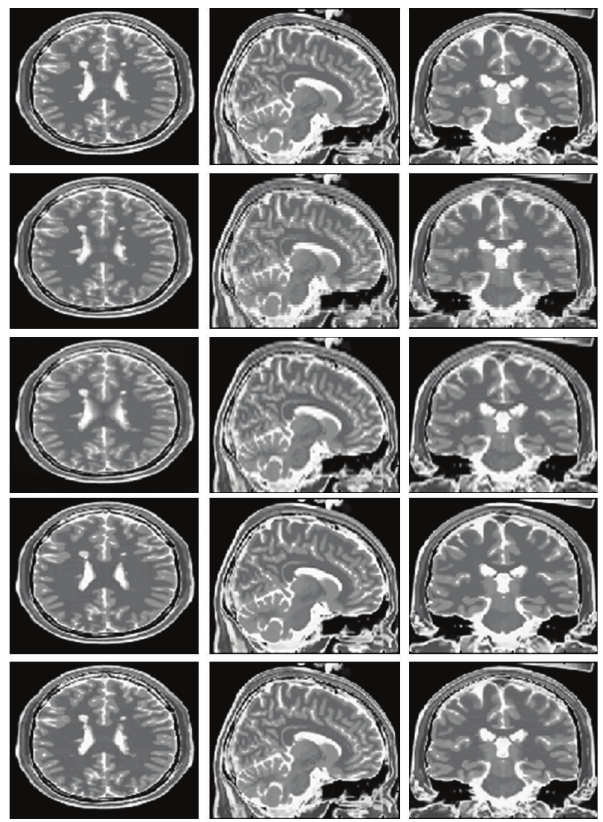
Figure 4: From top to bottom: Original Axial, Sagittal and Coronal sections of the HR T2 data, NN interpolation, B-Spline interpolation, Rousseau’s method and proposed reconstruction. We have the results for 3mm slice thickness reconstruction. Note that MS lesions are better reconstructed using the proposed